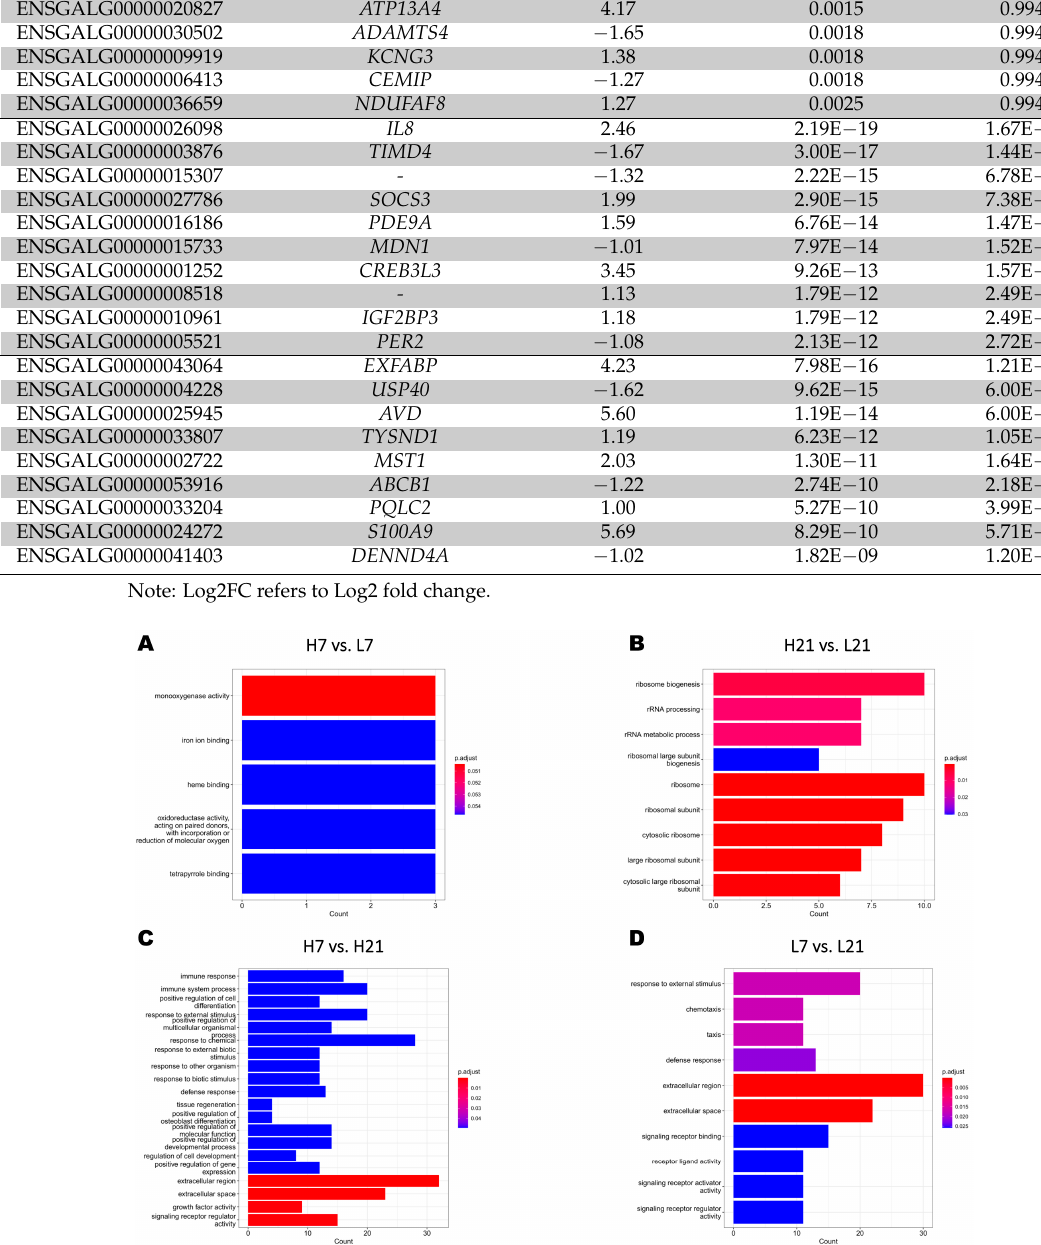
Figure 4. Kyoto Encyclopedia of Genes and Genomes (KEGG) pathways enrichment of different groups. H7: High H/L SE-infected 7 dpi (n = 6); L7: Low H/L SE-infected 7 dpi (n = 7); H21: high H/L SE-infected 21 dpi (n = 5); L21: Low H/L SE-infected 21 dpi (n = 4).